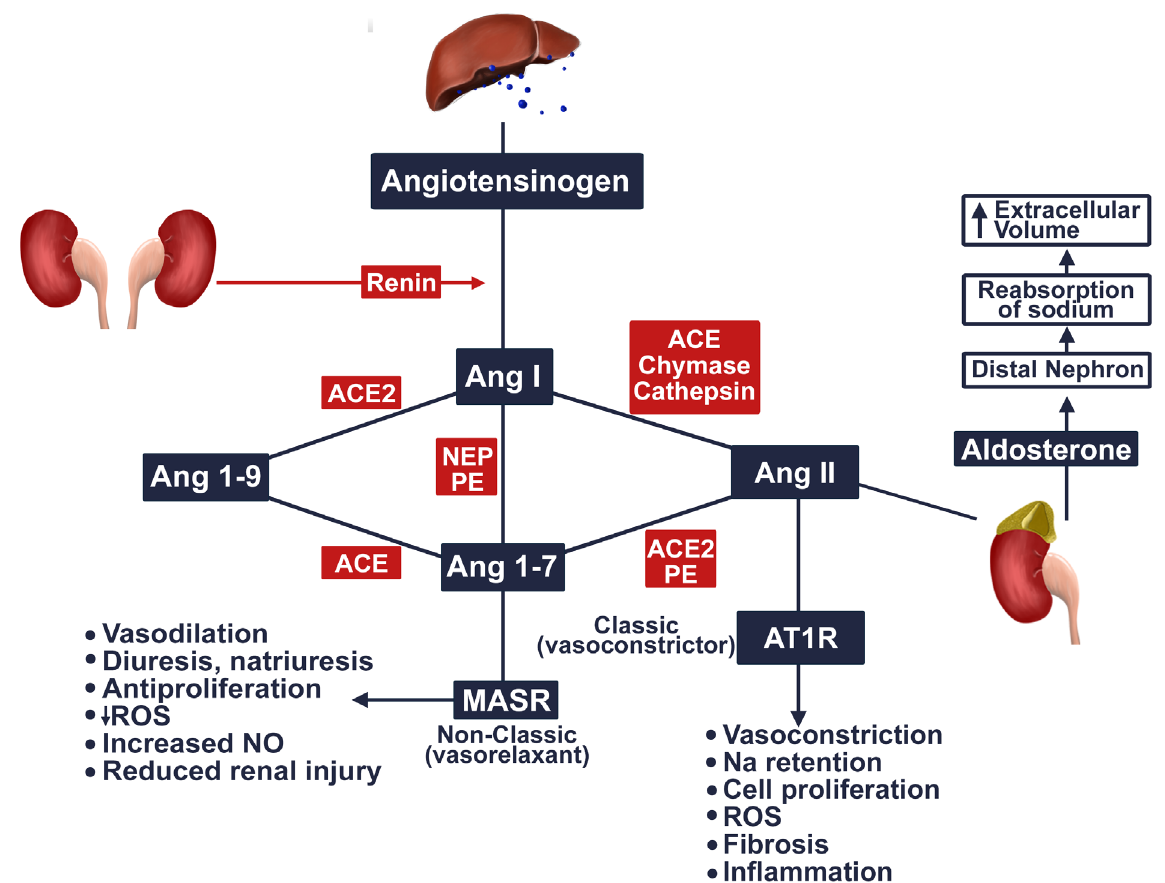
Figure 1. Classical and non-classical axis of the renin angiotensin aldosterone system. Renin, produced in the kidneys, cleaves the angiotensinogen synthesized in the liver to form angiotensin (Ang) I, which will later be converted into Ang II through the action of the Angiotensin-Converting Enzyme (ACE). Other enzymes, including chymase and cathepsin, serve as an alternative pathway for converting Ang I to Ang II. Ang I also serves as a substrate for neprilysin (NEP) and prolyl endopeptidase (PE), which cleaves it to form Ang 1-7. Furthermore, PE is able to cleave Ang II into Ang 1-7. Another important enzyme for the functioning of this system is the ACE2, responsible for the transformation of Ang I into Ang 1-9 and Ang II into Ang 1-7. Ang II, in addition to stimulating the production of aldosterone in the adrenal gland, binds to its AT1 receptor (AT1R) to activate the classic axis of this system. On the other hand, Ang 1-7 binds to its MAS receptor (MASR), activating the non-classical axis, capable of neutralizing the vasoconstrictor